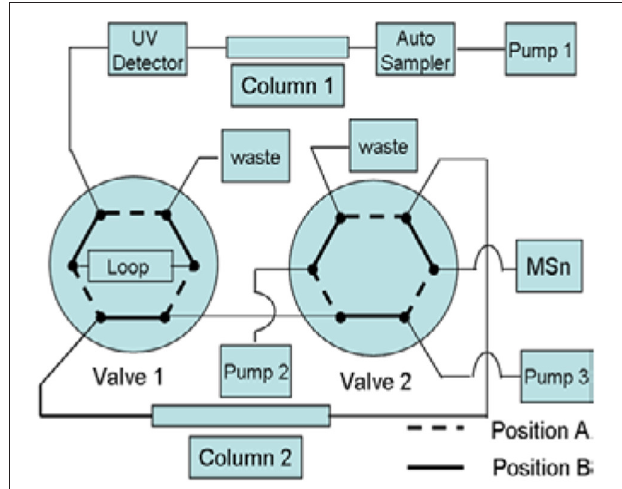
FIGURE 2 | Schematic diagram of column switching.